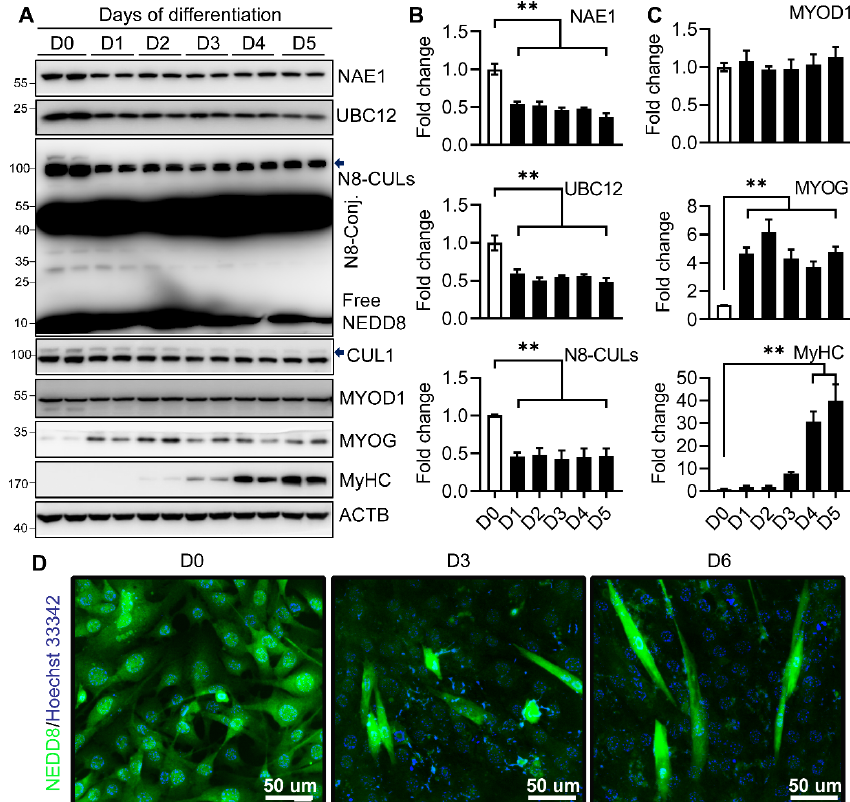
Figure 1. Neddylation is differentially regulated during C2C12 differentiation. ( A–C ) Western blot of the indicated proteins ( A ), and quantifications of NAE1, UBC12, and neddylated Cullins (N8-CULs) ( B ); quantifications of MYOD1, MYOGENIN, and MYOSIN (skeletal, fast) (MyHC) ( C ) in proliferative C2C12 cells cultured in growth media (i.e., day 0, D0) and for the indicated days after differentiation induction (D1 to D5). Proteins were quantified and normalized to ACTB. Data were presented as fold changes with D0 cells set at 1. N8-Conj.: NEDD8-conjugated. Arrows indicate neddylated CULs and CUL1. ( D ) Representative immunofluorescence images of C2C12 cells stained with NEDD8 (green) in growth media (D0) and for 3 and 6 days in differentiation media (D3, D6). Nuclei were counterstained with Hoechst 33342. Scale bars: 50 μ m. ** p < 0.005 versus D0. One-way ANOVA. Three independent experiments.